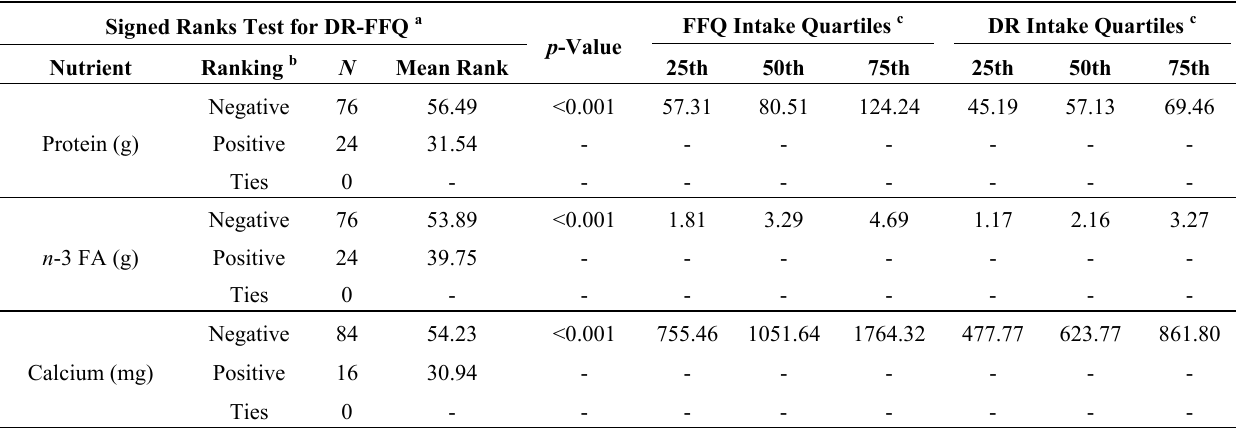
Table 3. Comparison of nutrient intakes between the vegan FFQ and three 24-h diet recalls using signed ranks test and quartile ranking for